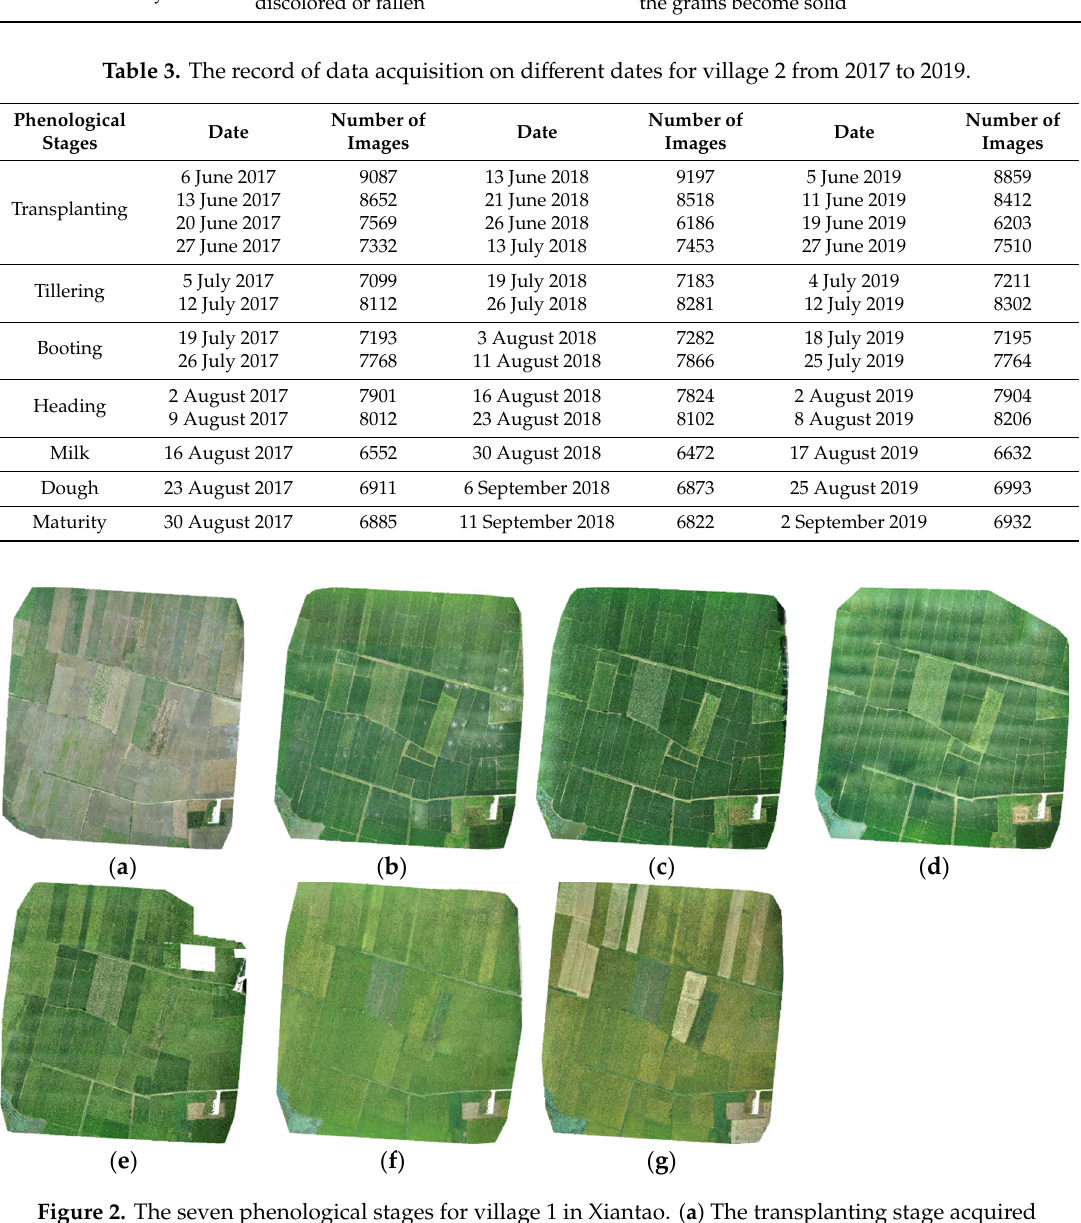
Figure 2. The seven phenological stages for village 1 in Xiantao. ( a ) The transplanting stage acquired on 13 June 2018; ( b ) the tillering stage acquired on 13 July 2018; ( c ) the booting stage acquired on 19 July 2018; ( d ) the heading stage acquired on 3 August 2018; ( e ) the milk stage acquired on 16 August 2018; ( f ) the dough stage acquired on 30 August 2018; ( g ) the maturity stage acquired on 11 September